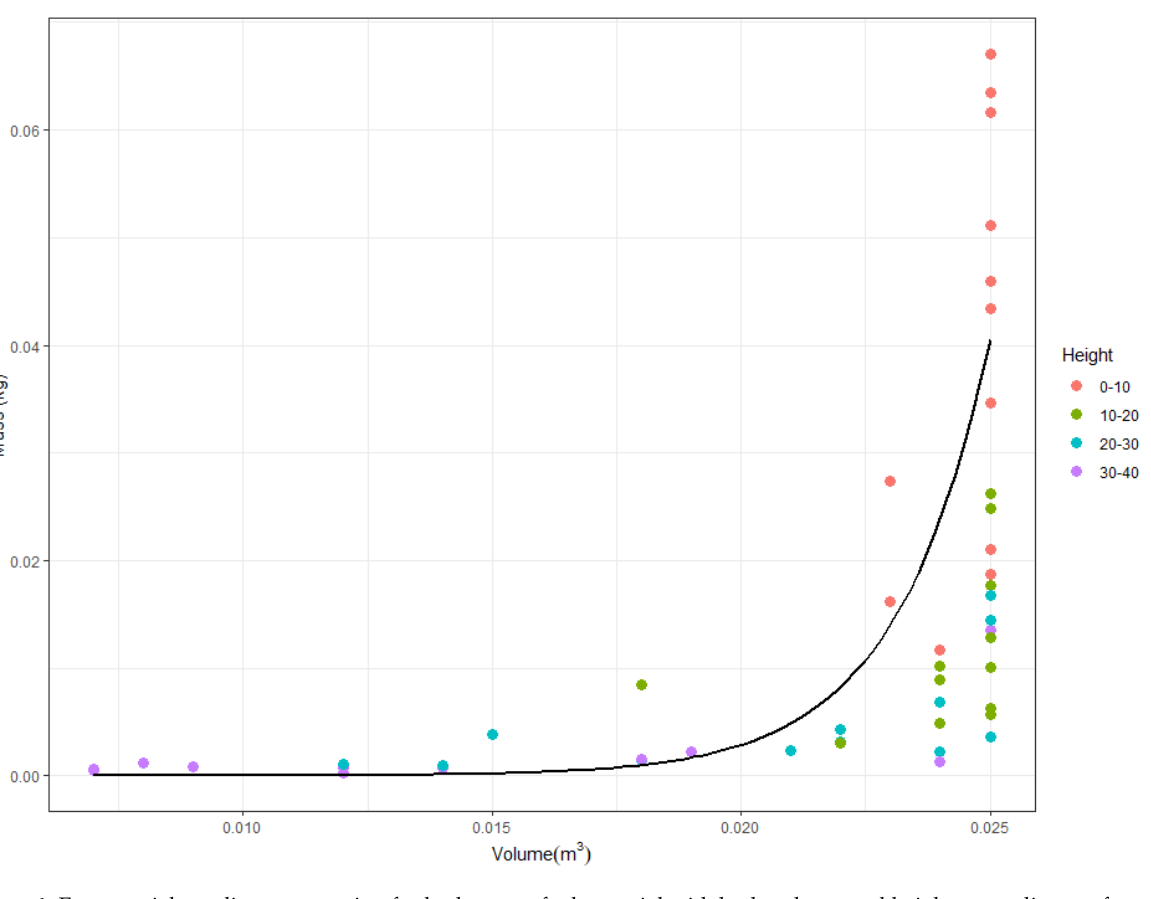
Figure 4. Exponential, nonlinear regression for herbaceous fuel material with both volume and height as predictors of mass. Only mass and volume observations associated with the strata between 0 and 70 cm were included. Using this equation, loading was calculated for each plot pre-fire using the voxelized volume and height (Figure 3). The median ( ± IQR) fuel consumption was 56.55 ± 10.52 g (Table 3). For the paired plots, the median (±IQR) fuel consumption was 68.41 ± 22.74 g (Table 3).